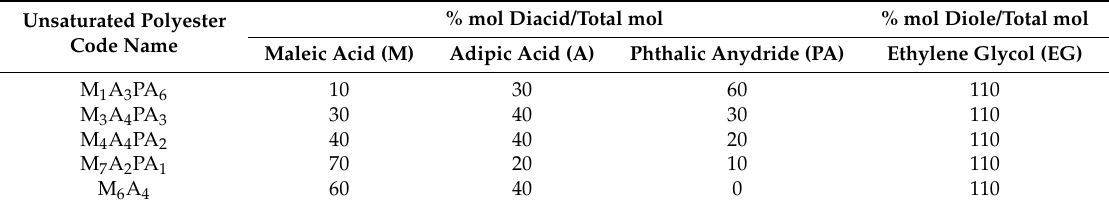
Table 1. The raw materials used for the synthesis of the unsaturated polyesters (feed